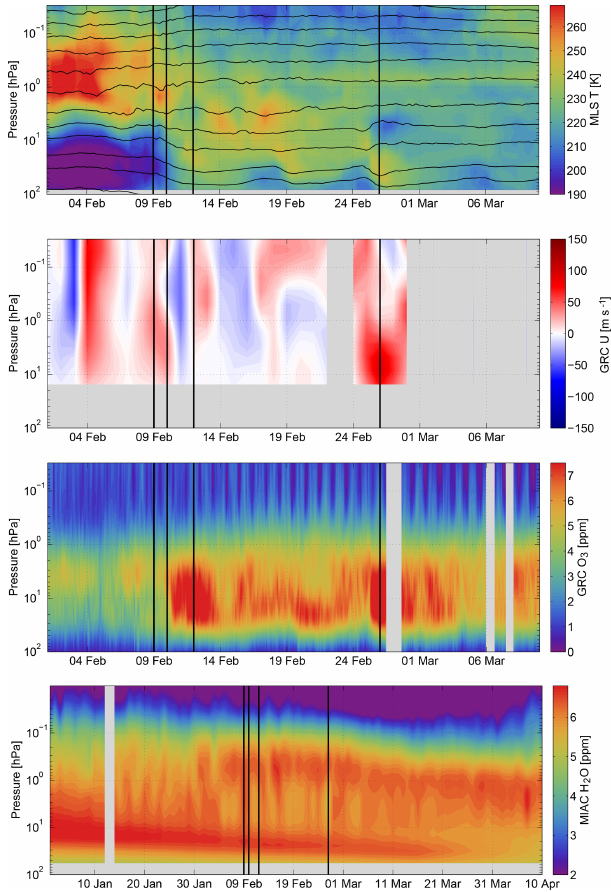
Figure 13. Time series of MLS temperature with isolines of poten- tial temperature (horizontal black lines), GROMOS-C zonal wind, GROMOS-C ozone and MIAWARA-C water vapour during the SSW 2018 at Ny-Ålesund. Note the different time axis for the water vapour time